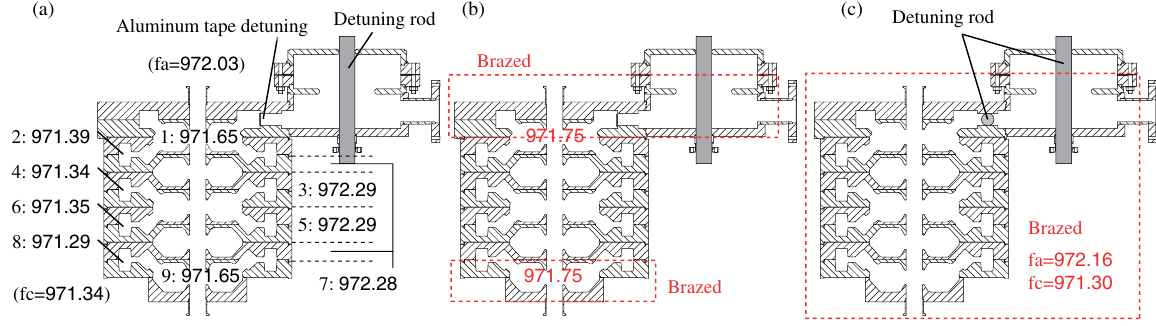
FIG. 7. Variation in the cell frequencies of accelerating tank 2 due to the brazing